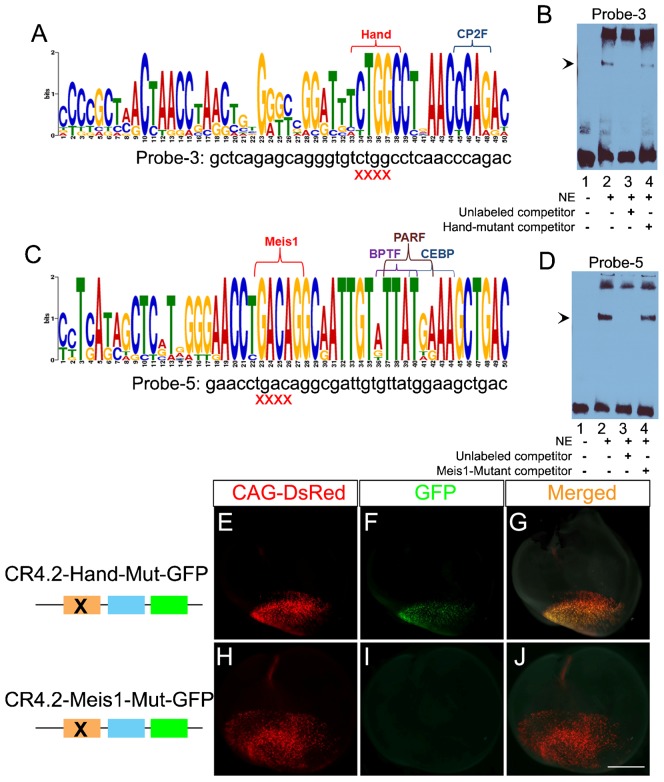
Meis1 transcription factor is essential for CR4.2-GFP expression.Analysis of homologous CR4.2 sequences from 11 species by Motif-based sequence analysis tools MEME (Bailey et al., 2006) revealed two highly conserved motifs (A,C). Electrophoretic mobility shift assays (EMSA) were performed using nuclear extracts isolated from E6 chick retina. Probe-3 (lane 2 in panel B) and Probe-5 (lane 2 in panel D) resulted in a band shift (arrowhead). This band disappeared with unlabeled competitors (lane 3); and the band reappeared with mutant competitors (lane 4). Mutant probes were synthesized with a 4 bp deletion of the TFBSs Hand (CTGG) (A) and Meis1 (TGAC) (C). (E–J) Chick retinas were injected and electroporated with a mixture of control CAG-DsRed (E,H) and a CR4.2-GFP mutant constructs (F,I) on embryonic day 4 (E4). Mutant constructs were generated by site directed mutagenesis. Transfected retinas were harvested and examined for GFP expression at E6. No change in reporter GFP expression was observed with deletion of Hand site (F); while no GFP expression was detected with deletion of Meis1 site (I). Scale bar: 1 mm.